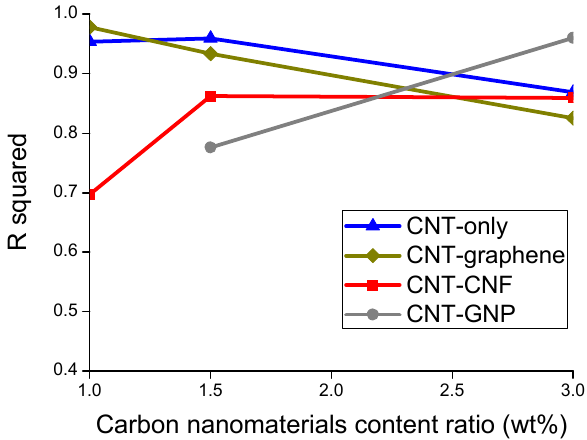
Figure 9. Scattered points derived from the relationship between the electrical resistance change rate and stress change of ( a ) the epoxy-based composites incorporating 1% CNT–CNF and ( b ) the epoxy-based composites incorporating 3% CNT–CNF during the piezoresistive sensing test.